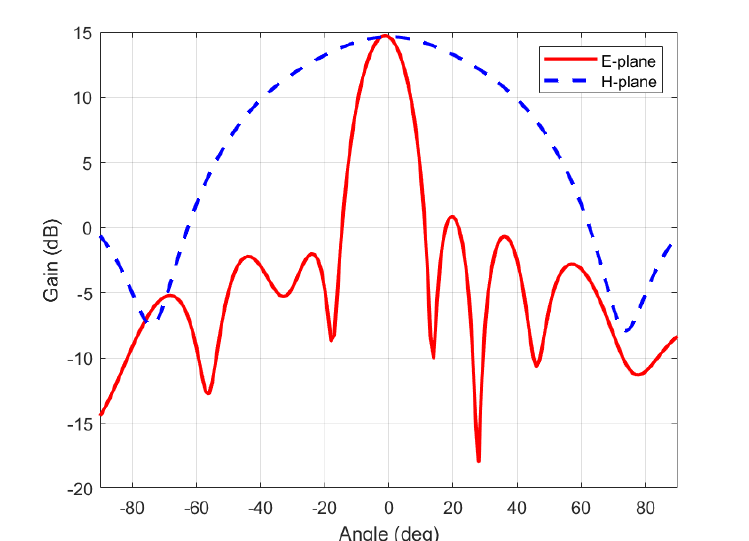
Figure 3. Simulation of the gain of the antenna including the cover.